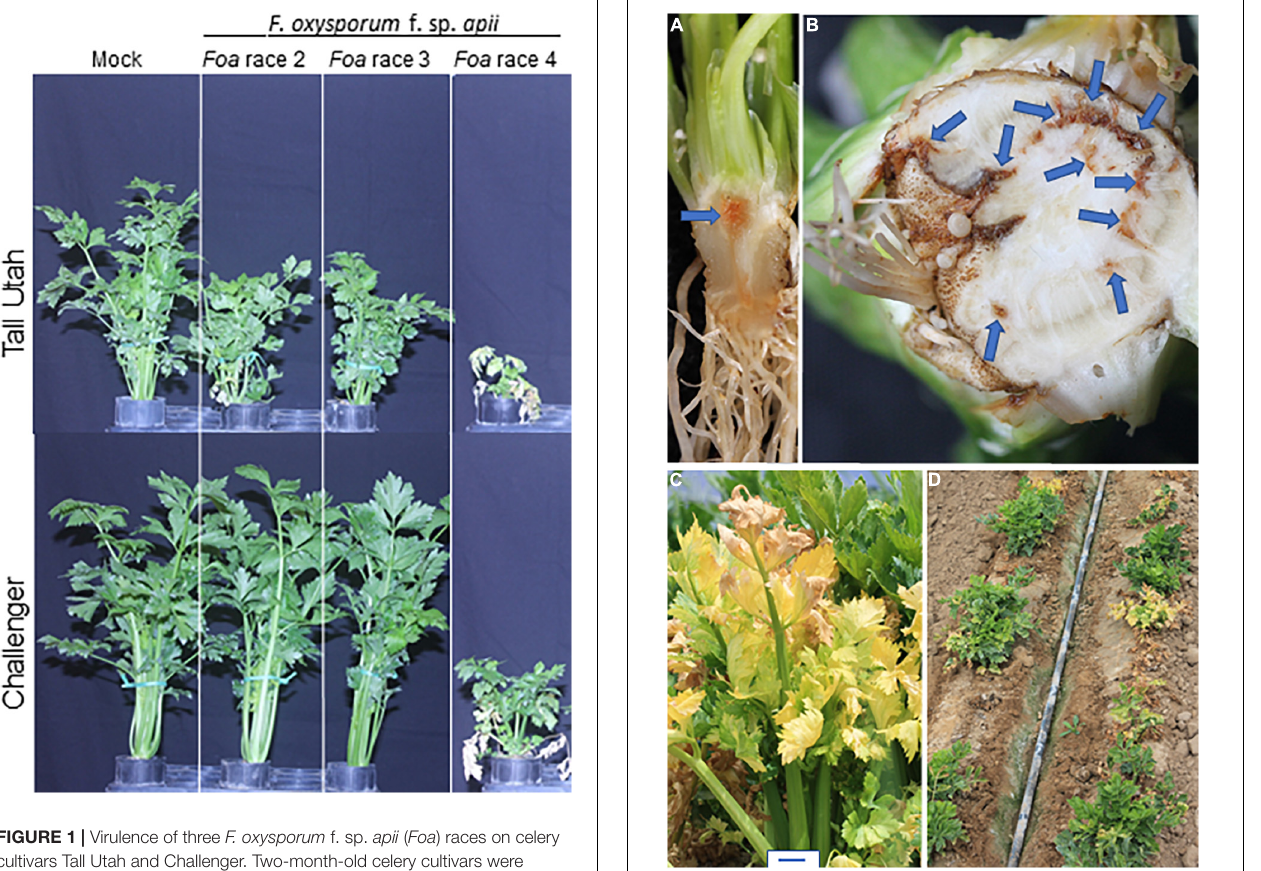
rapid death. Fibrous roots are sloughed off and the taproot is often rotted. With Foci in coriander, the vascular discoloration is reddish to light